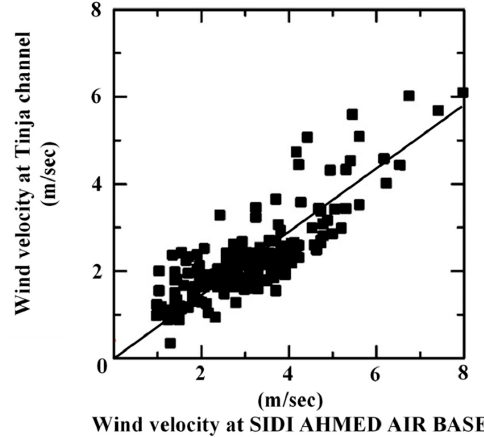
Figure 21. The comparison of wind velocities between Sidi Ahmed Air Base and Tinja channel for the observation periods.